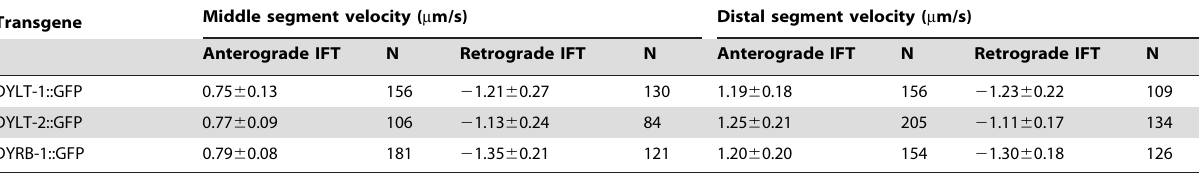
Transgene Middle segment velocity ( m